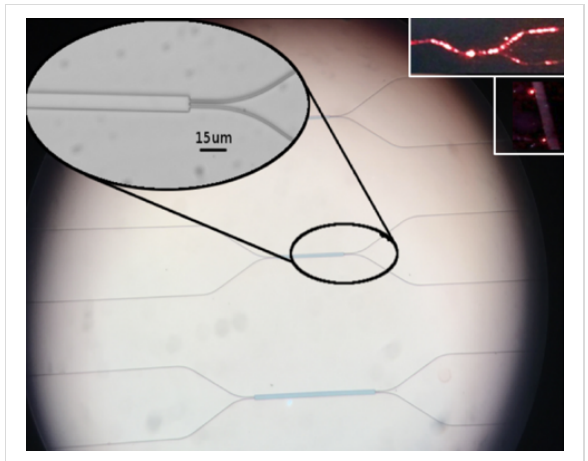
Figure 6: A number of SU8 PWG MMIs of different lengths prepared at the lab. The substrate is SiO 2 on an Si wafer; the LC cladding is not deposited yet. Upper inset: MMI configured for a 100:0 coupling. Lower inset: outputs (about 95:5).